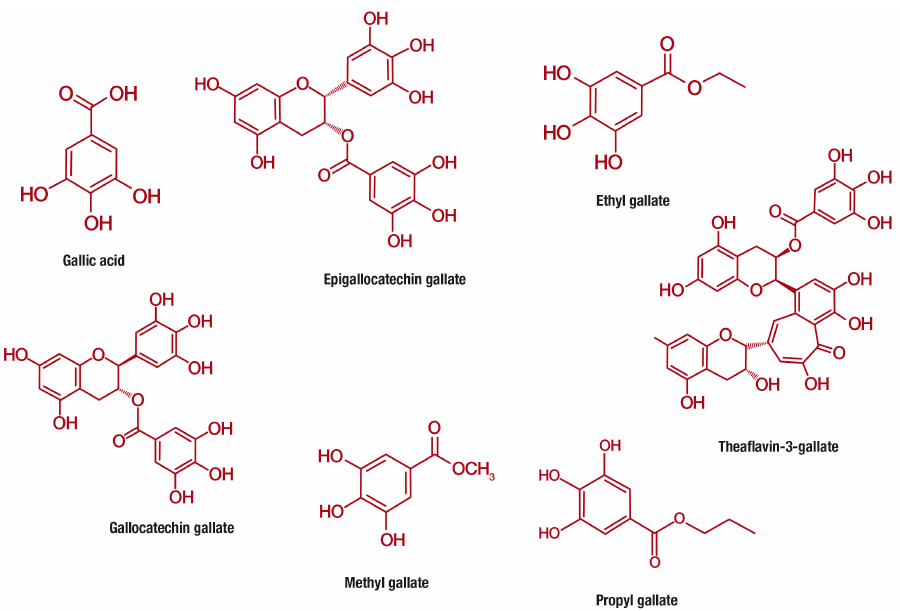
Figure 3. Chemical structures of gallic acid and its derivative compounds, including epigallocatechin gallate, ethyl gallate, gallocatechin gallate, methyl gallate, propyl gallate, theaflavin-3-gallate that are increasingly studied for their anti-obesity properties.